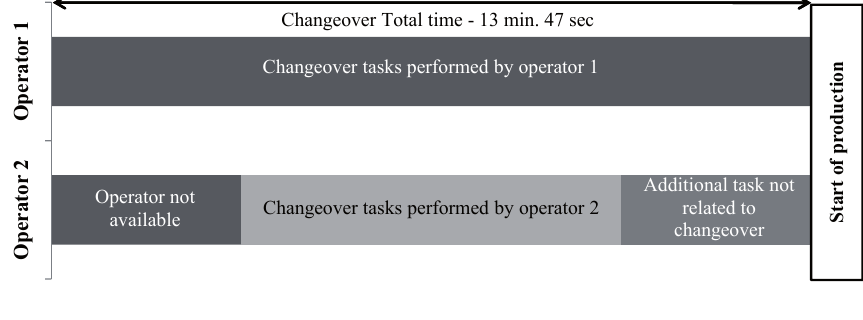
Fig. 3 – Changeover process visualization – simplified (Source: